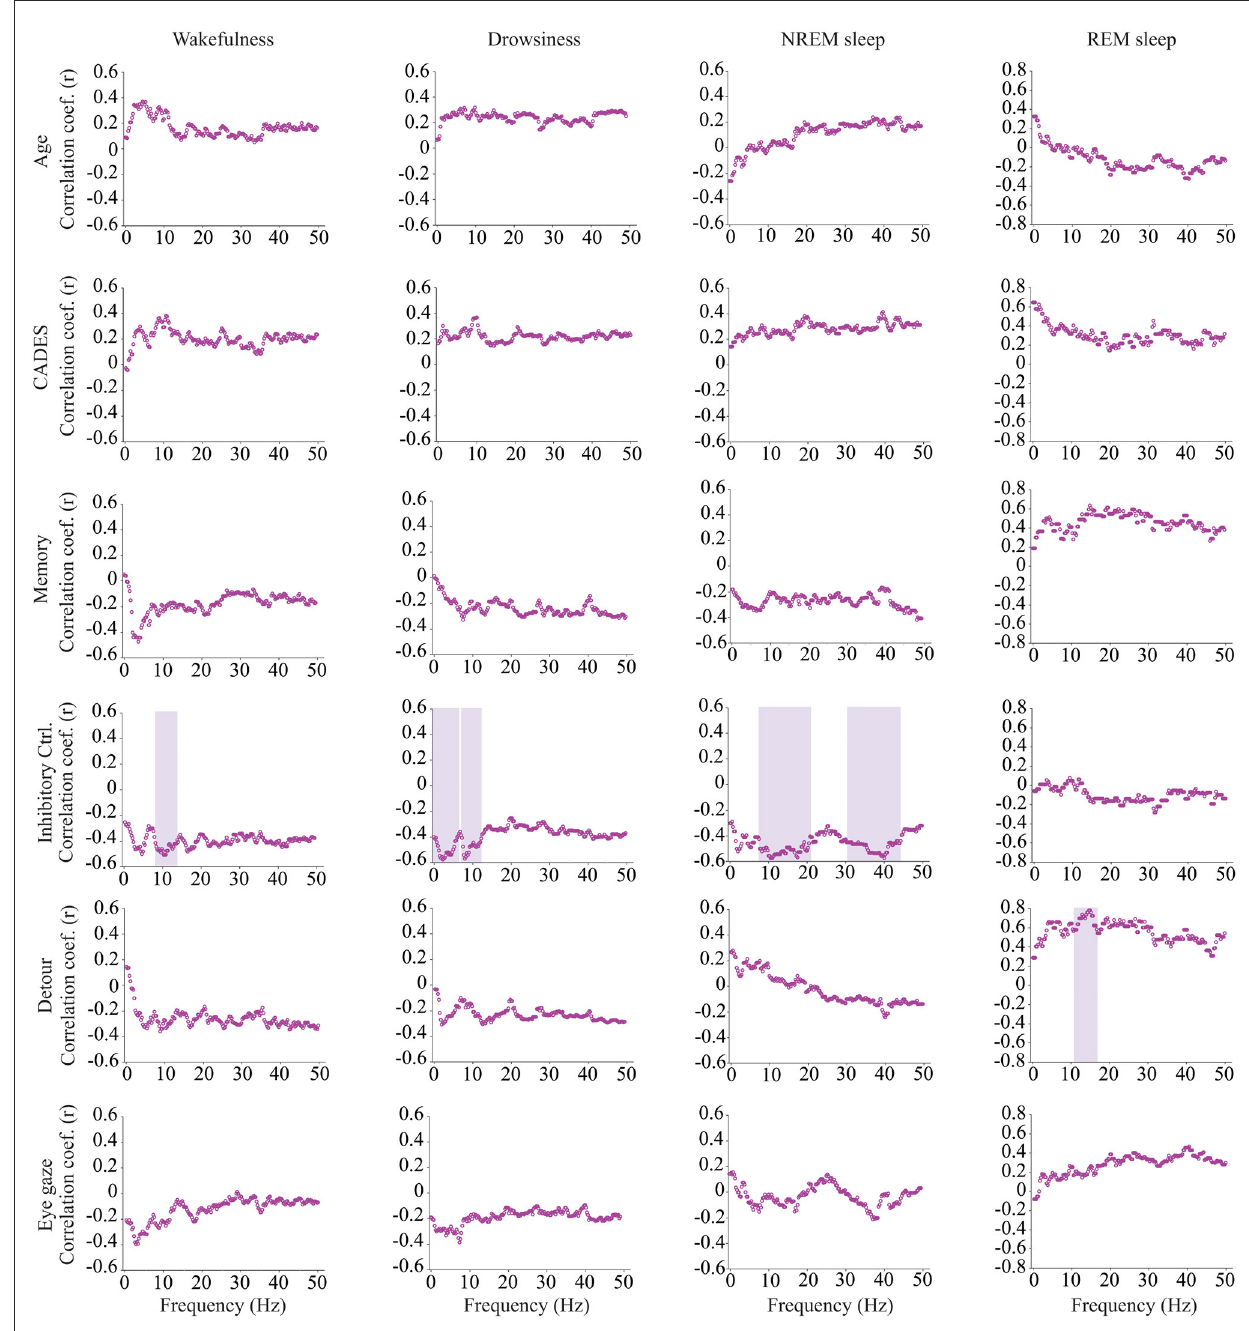
FIGURE6 Correlations between EEG intrahemispheric (Fz-Cz) coherence and age, CADES score, or performance in cognitive tests. Spearman correlation coefficients are shown for each frequency bin. Frequencies with significant correlations are indicated with a purple shadow box. The analysis included only the dogs that entered each specific behavioral state (wakefulness n = 28, drowsiness n = 26, and NREM sleep n =